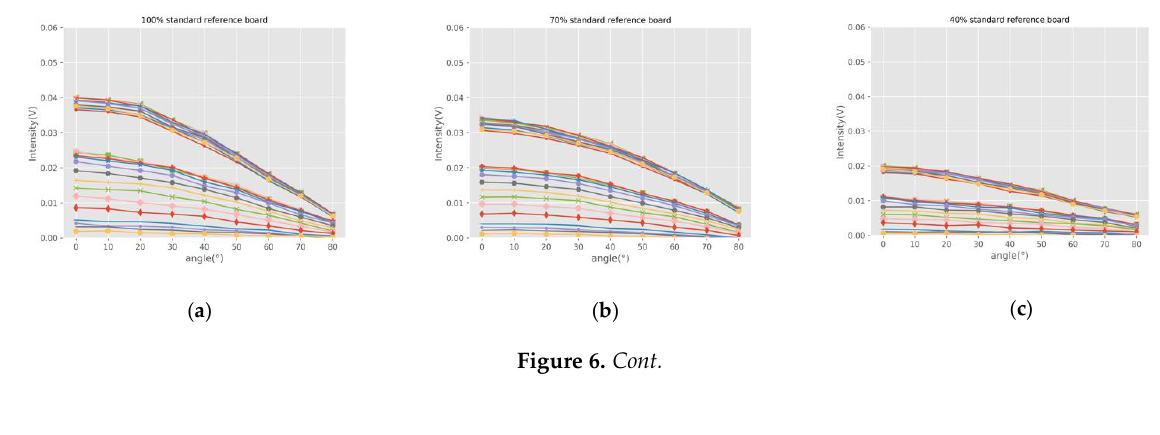
Figure 5. Reflectance comparison of HSL and SVC spectrometer. ( a ) 70% standard reference board; ( b ) 40% standard reference board; ( c ) Wood product; ( d ) Sidewalk brick; ( e ) Ficus elastic; ( f ) Codiaeum variegatum; ( g ) Marble tile; ( h ) Floor tile; ( i ) Car shell sample.